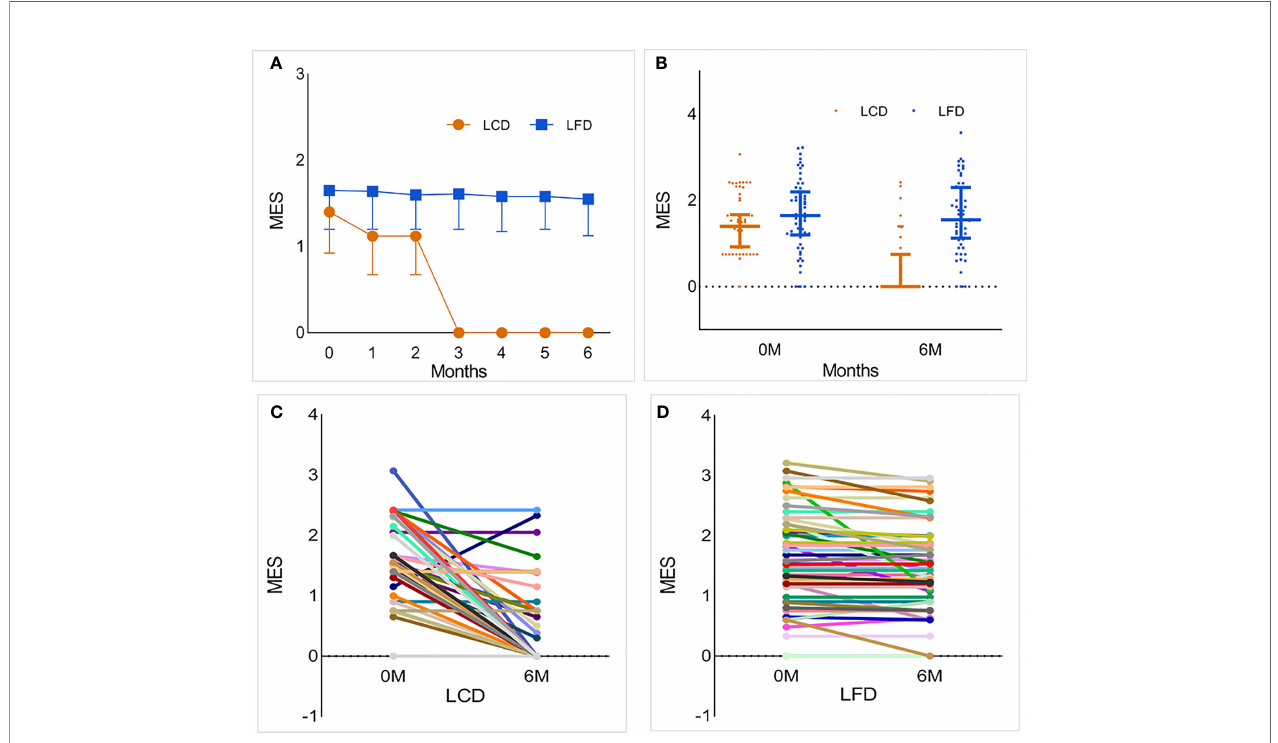
FIGURE 5 | The change and distribution of MES in each group. Most participants in LCD group experienced a period of antiglycemic medications withdrawal. (A, B) The foldline and scatter diagram of MES in the two groups. While the blood glucose was stable, the MES of a part of participants in LCD group was zero, which means that they realized medications withdrawal only under the condition of diet restriction. This change was particularly evident after 3 months. However, there was no signi fi cant change in LFD group. (C) Changes in MES for each participant in the LCD group. Most participants experienced a period of antiglycemic medication withdrawal. (D) Changes in MES for each participant in the LFD group. Compared with baseline, most participants had no change or slight decrease in MES. LCD, Low- carbohydrate diet; LFD, Low-fat diet; MES, medication effects